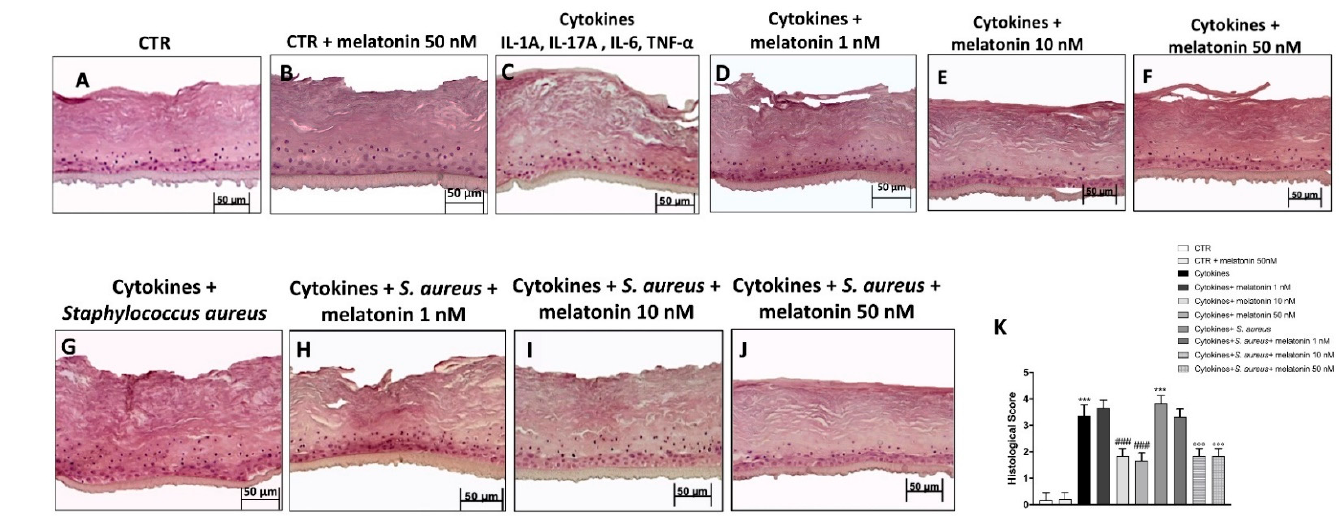
Figure 3. Effect of melatonin on histological damage. HE staining revealed that the cytokines and S. aureus groups were characterized by loss of structural integrity and thickening of the stratum corneum compared to the control group and control group + melatonin at the higher concentration 50 nM ( A – C ). However, the treatment with melatonin at 10 nM and 50 nM ( E , F , I , J ) significantly restored structural integrity; more than the melatonin treatment at the concentration of 1 nM ( D – H ). Data are representative of at least three independent experiments. ( K ) *** p < 0.001 vs. CTR; ### p < 0.001 vs. cytokines group. °°° p < 0.001 vs. cytokines + S. aureus group.